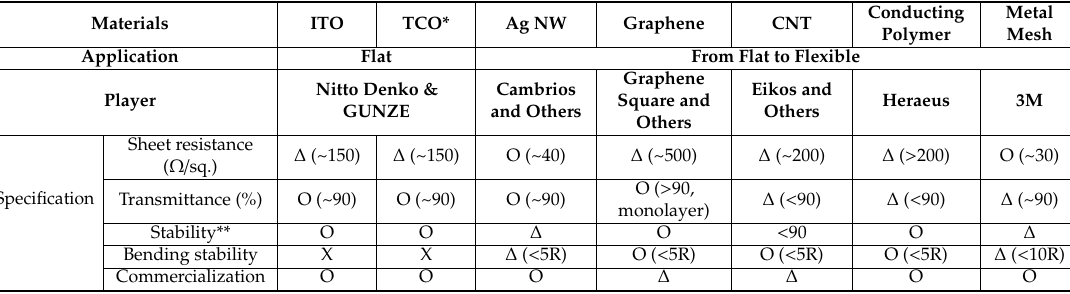
Table 1. Comparison of performance of TCE materials for electro-optical devices [1–5]. Conducting Metal Materials ITO TCO* Ag NW Graphene CNT Polymer Mesh Application Flat From Flat to Flexible Graphene Nitto Denko & Cambrios Eikos and Player Square and Heraeus 3M GUNZE and Others Others Others Sheet resistance ∆ (~150) ∆ (~150) O (~40) ∆ (~500) ∆ (~200) ∆ ( > 200) O (~30) ( Ω / sq.) O ( > 90, ∆ ( < 90) ∆ ( < 90) ∆ (~90) Specification Transmittance (%) O (~90) O (~90) O (~90) monolayer) Stability** O O ∆ O < 90 O ∆ Bending stability X X ∆ ( < 5R) O ( < 5R) O ( < 5R) O ( < 5R) ∆ ( < 10R) Commercialization O O O ∆